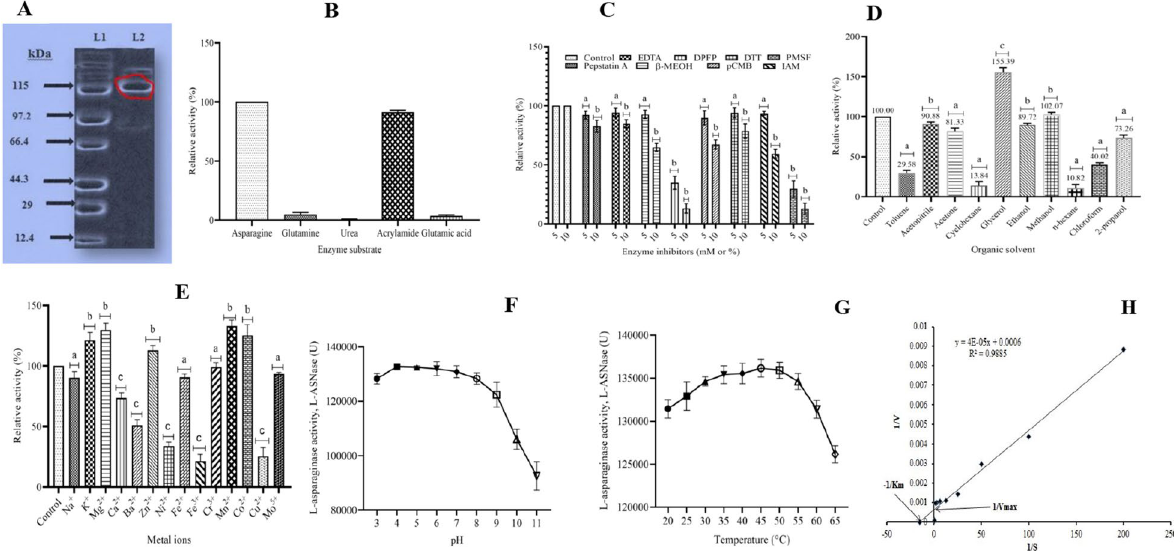
Fig. 3 Characterization of Fusant-06 L-ASNase A SDS-PAGE molecular weight analysis; Lane 1 ( L1 ) shows protein standards and Lane 2 ( L2 ) the purified Fusant-06 L-ASNase B Substrate specificity C Inhibitor stability—bars with letter ‘a’ are significantly different from control; bars with letter ‘b’ are not significantly different from control D Organic solvent stability E metal ions F pH G temperature enzyme activity H Michealis –Menton kinetics of Fusant-06 l -ASNase. Values are means of triplicate determinations and error bars are standard deviations tested at 5% significance level. Error bars with letter ‘a’ are not significantly different from control; bars with letter ‘b’ significantly enhance l -ASNase activity; bars with letter ‘c’ significantly inhibit l